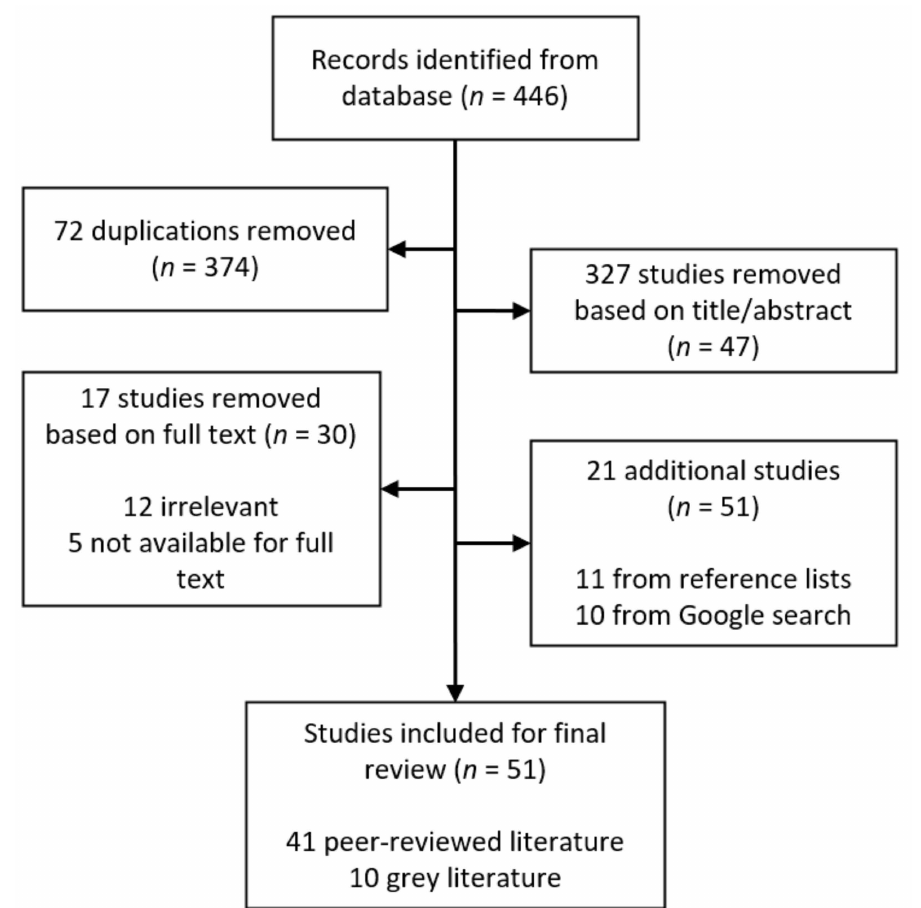
Figure 3. Flowchart of paper